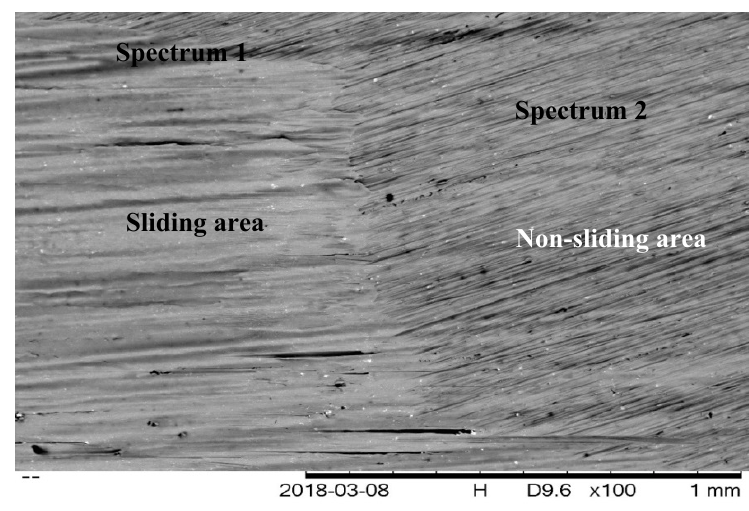
Figure 20. Front view of CNC-CuO based nano lubricant mechanism.